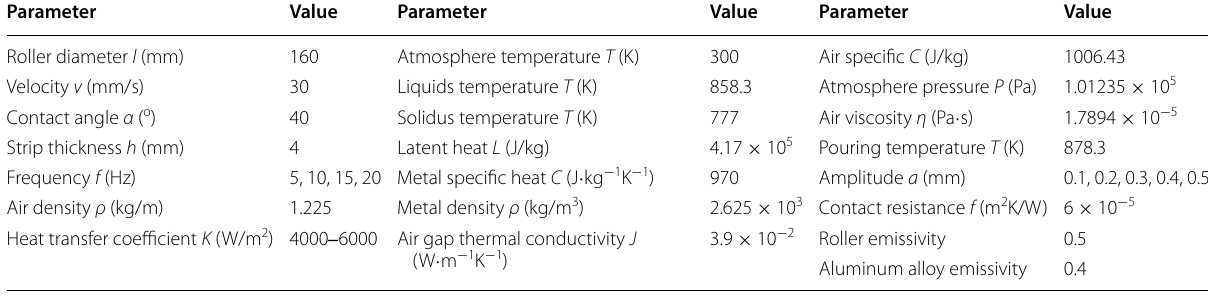
Table 1 Thermophysical properties and oscillating twin-roll strip casting parameters of AlSi9Cu3 aluminum alloy Parameter